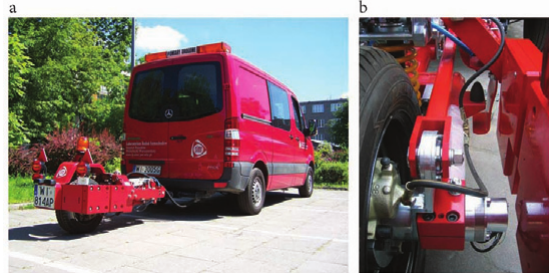
fig. 1. Measurement system – SRT-4: a – dynamometer trailer and towing vehicle; b – measurement wheel with brake callipers and trailing